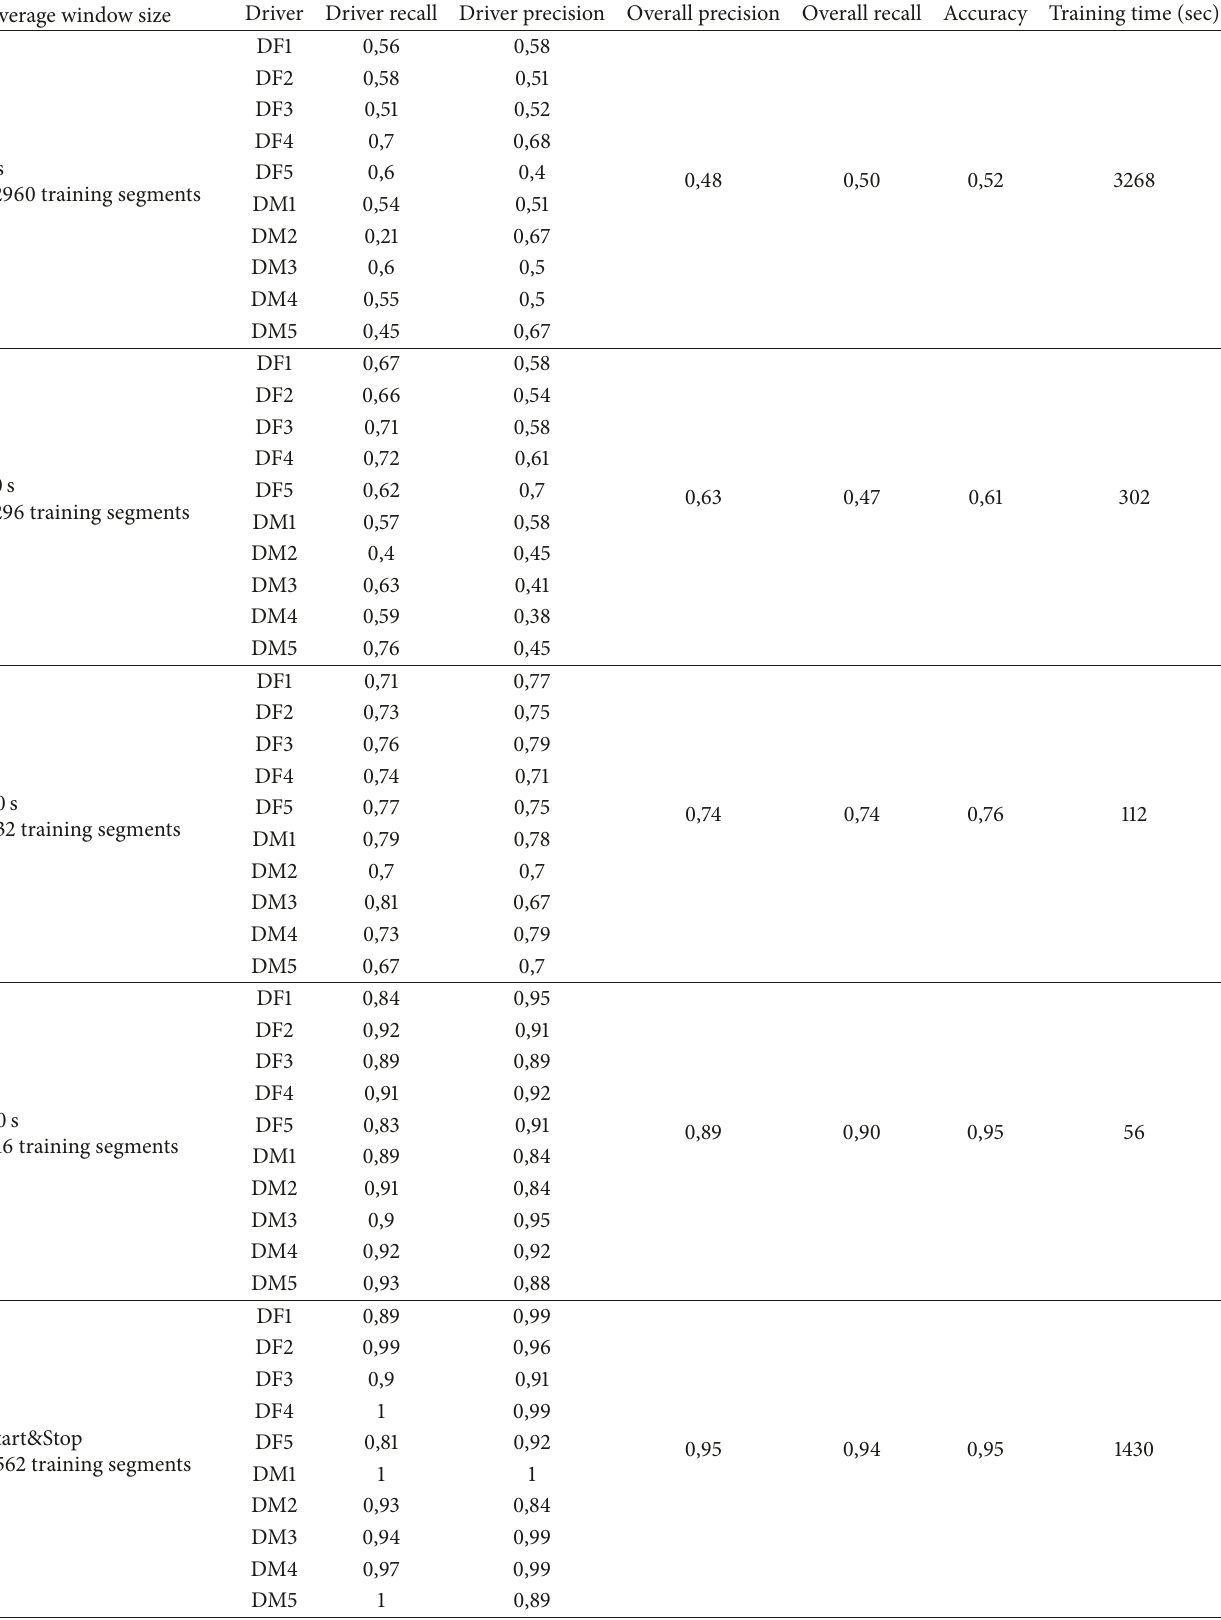
Table 5: 𝐸 12 , precision, recall, accuracy, and training time evaluated by using MLP for different windows sizes. Average window